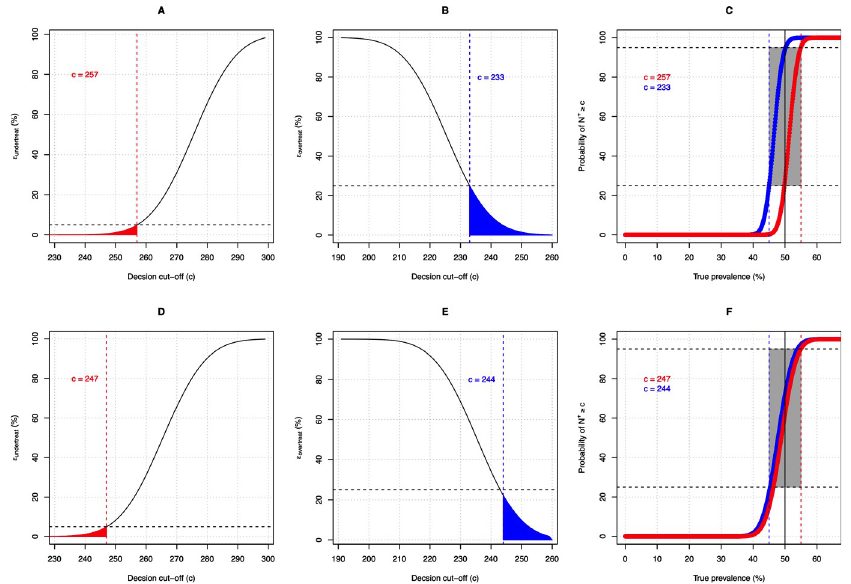
Fig 2. The process to determine the decision cut-off c in a LQAs framework. The different panels in this figure illustrate the process to determine the decision cut-off c when 500 subjects ( N tot ) are randomly recruited for both a ) = specificity ( Sp ) = 100%; Panels A–C ) and an imperfect test ( Se = Sp = 80%); Panels perfect test (sensitivity ( Se d d d d D–F ). Panels A and D represent the cumulative error of prematurely reducing the preventive chemotherapy (PC) ( ε ) when the true underlying prevalence was arbitrarily set at 55% ( Prev ). The horizontal dashed line undertreat true � T represents a ε undertreat of 5%, the red dashed line represents the allowed possible decision cut-off c resulting in a ε undertreat � 5%. The red area under the curve highlight all possible values for c resulting in a ε undertreat � 5%. Panels B and E represent the cumulative error of selecting a PC frequency that is higher than needed ( ε overtreat ) when the true underlying prevalence was arbitrarily set at 45% ( Prev true < T ). The horizontal dashed line represents a ε overtreat of 25%, of � 25%. The blue area the blue dashed line represents the lowest possible decision cut-off c resulting in a ε overtreat under the curve highlights all possible values for c resulting in a ε overtreat of � 25%. Panels C and F represent the subjects being at least c over a probability (in %) of the number of positive test results ( N + ) in a random sample of N tot wide range of true underlying prevalence ( Prev true ) based on the two extreme decision cut-offs (red line: lowest possible value; blue line: highest possible value). The vertical straight line represents the program decision threshold T of 50%. The horizontal black dashed lines represent a ε overtreat equal to 25% and a ε undertreat equal to 5% (= 100% - 95%). The grey zone indicates the range of Prev true for which decision making is inadequate ( ε overtreat > 25% (blue dashed line) and ε > 5% (red dashed line). In this example, the grey zone ranges from 45% to 55% by undertreat